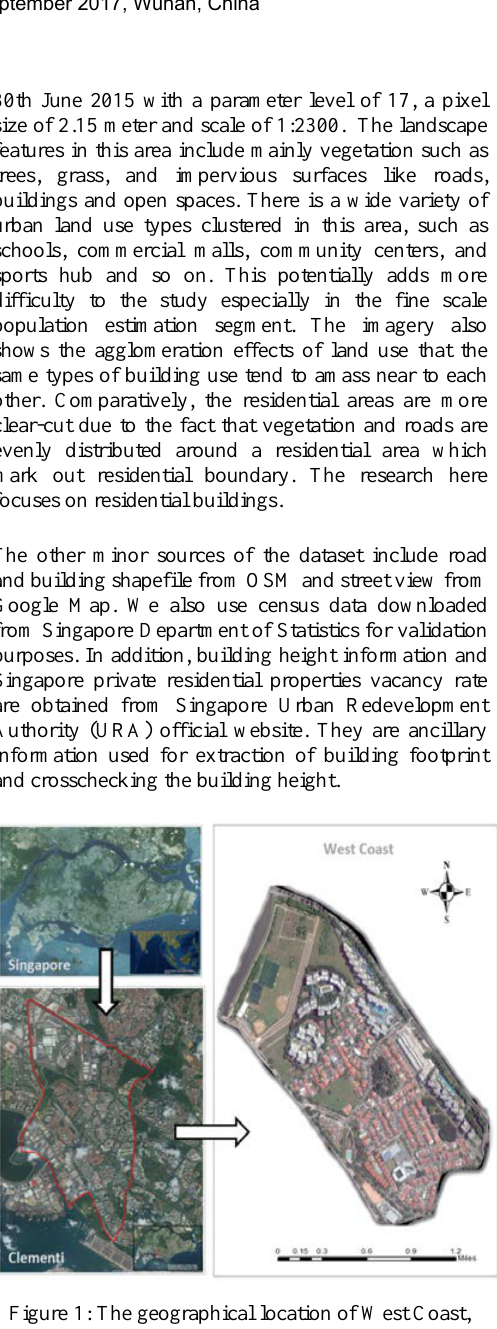
Figure 1: The geographical location of West